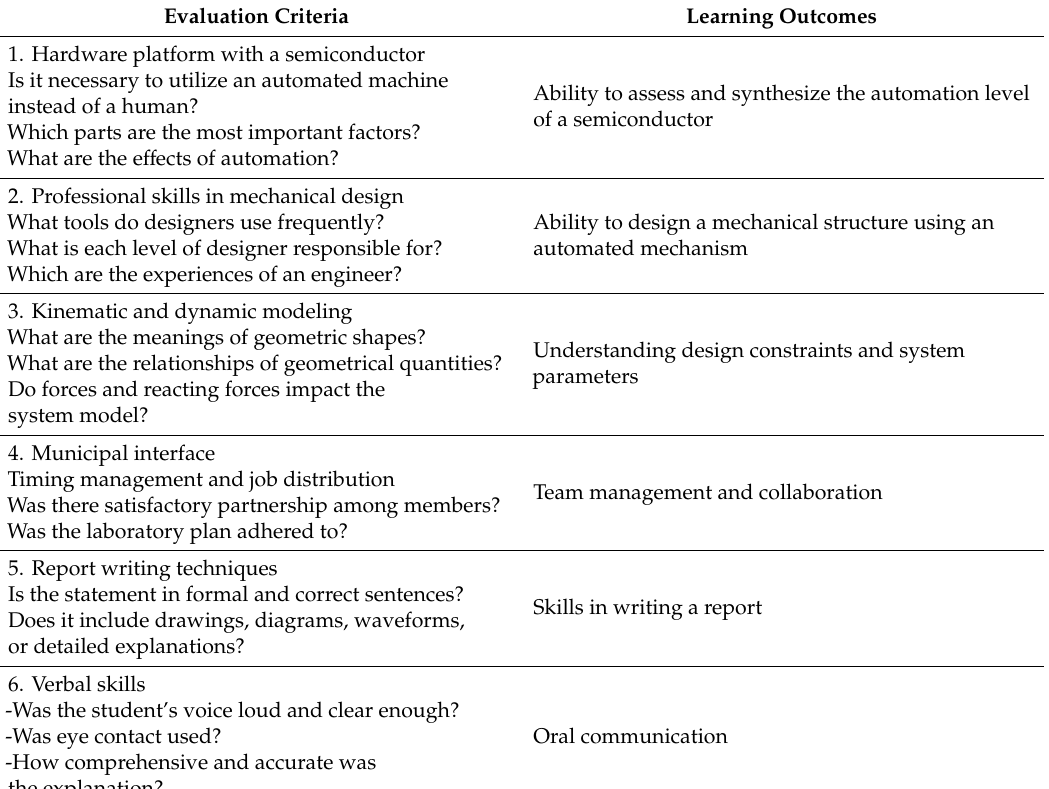
Table 9. Grading criteria and